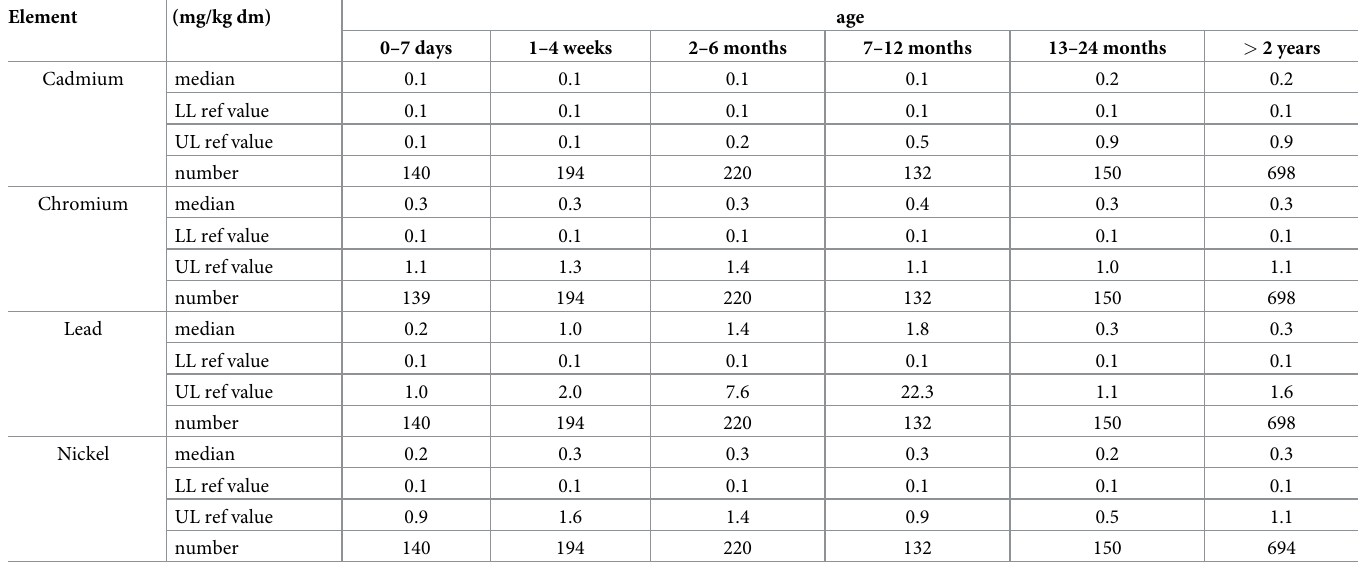
LL ref value Lower limit of reference interval (90%) UL ref value Upper limit of reference interval (90%) All results are expressed as mg/kg dm.